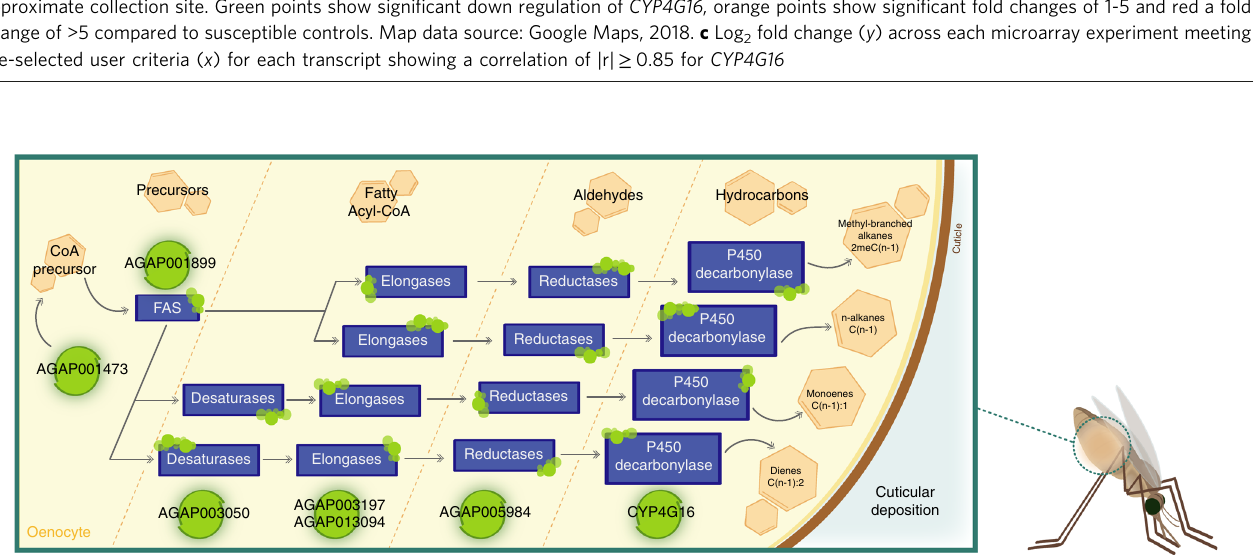
Fig. 6 Schematic of cuticular hydrocarbon synthesis in An. gambiae . Schematic showing the steps in cuticular hydrocarbon synthesis, adapted from Blomquist 1987 67 and Balabanidou et al. 51 , together with a list of putative members of each gene family in An. gambiae . All gene families are shown in blue and represent: FAS fatty acid synthases, elongases fatty acid elongases, reductases fatty acid reductases, desaturases fatty acid desaturases. General chemical classes at each step are shown in light red hexagons. Highlighted in green circles are the transcripts present in the correlation network of CYP4G16 . The correlation network is signi fi cantly enriched for this pathway p (hypergeometric test) = 1.44e − 12 . Figure created expressly for this manuscript by Manuela